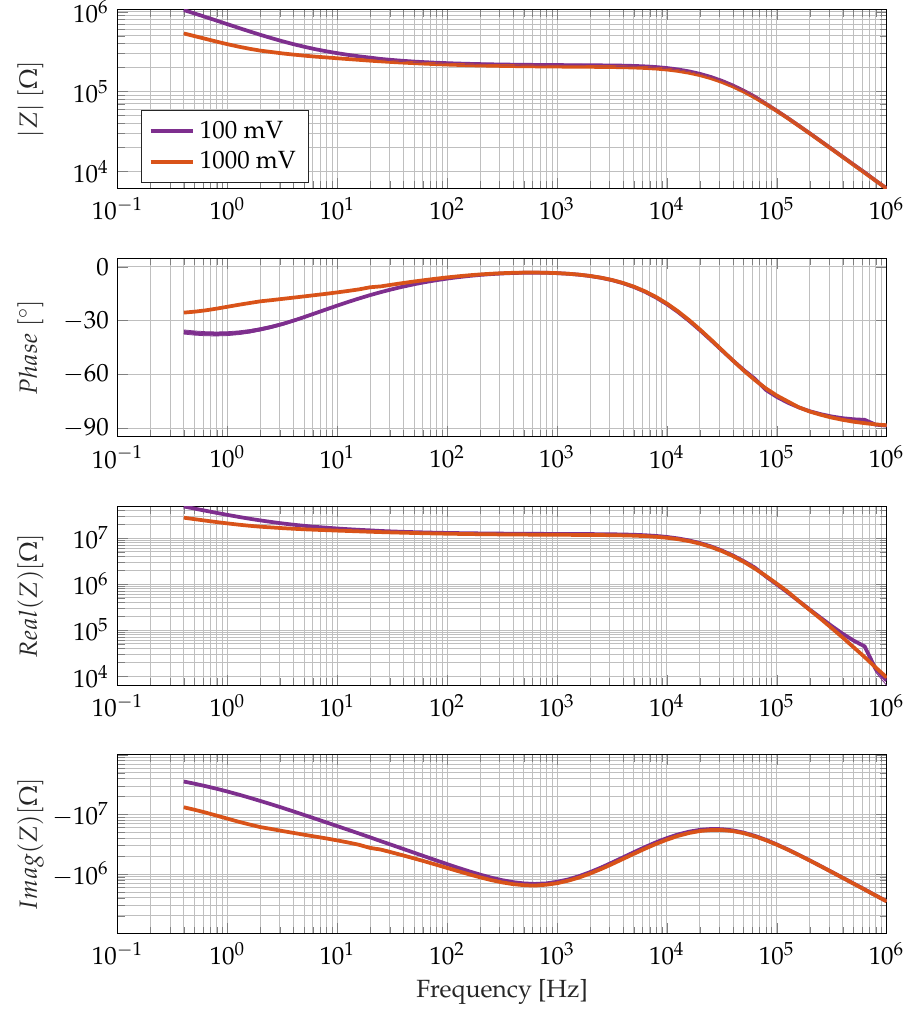
Figure 7. Impedance spectrum of a sensor consisting of interdigitated electrodes in isopropanol at different measurement voltages. For each voltage, the averages of five measured spectra are shown with the standard deviation indicated by thin lines of the same colour. The differences in the low-frequency range are